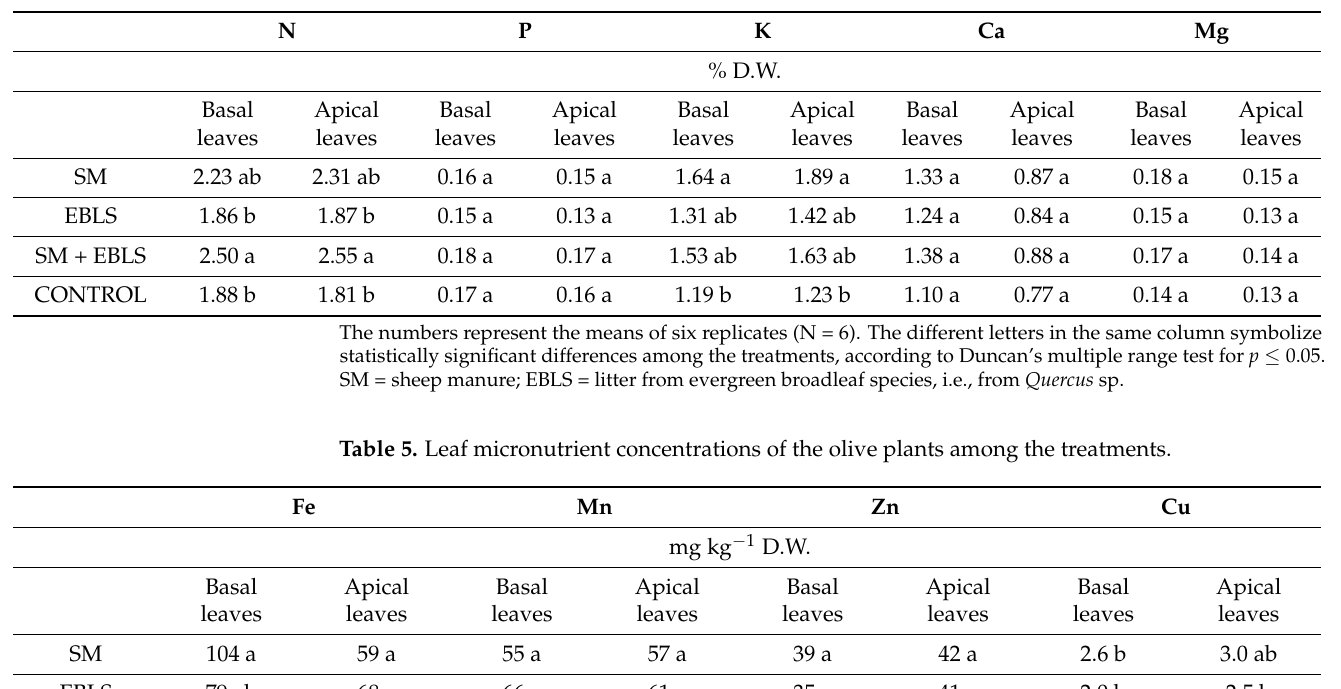
Table 4. Leaf macronutrient concentrations of the olive plants among the treatments.